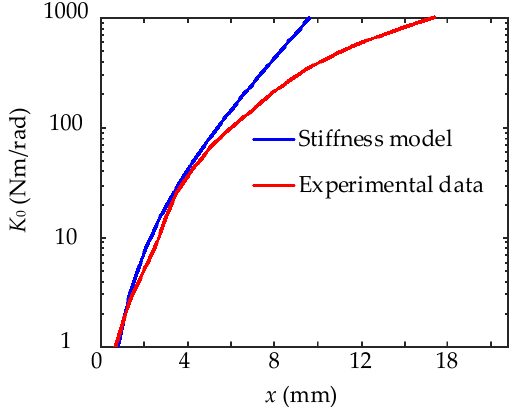
Figure 21. Fitting curve of experimental values and model values of K 0 .